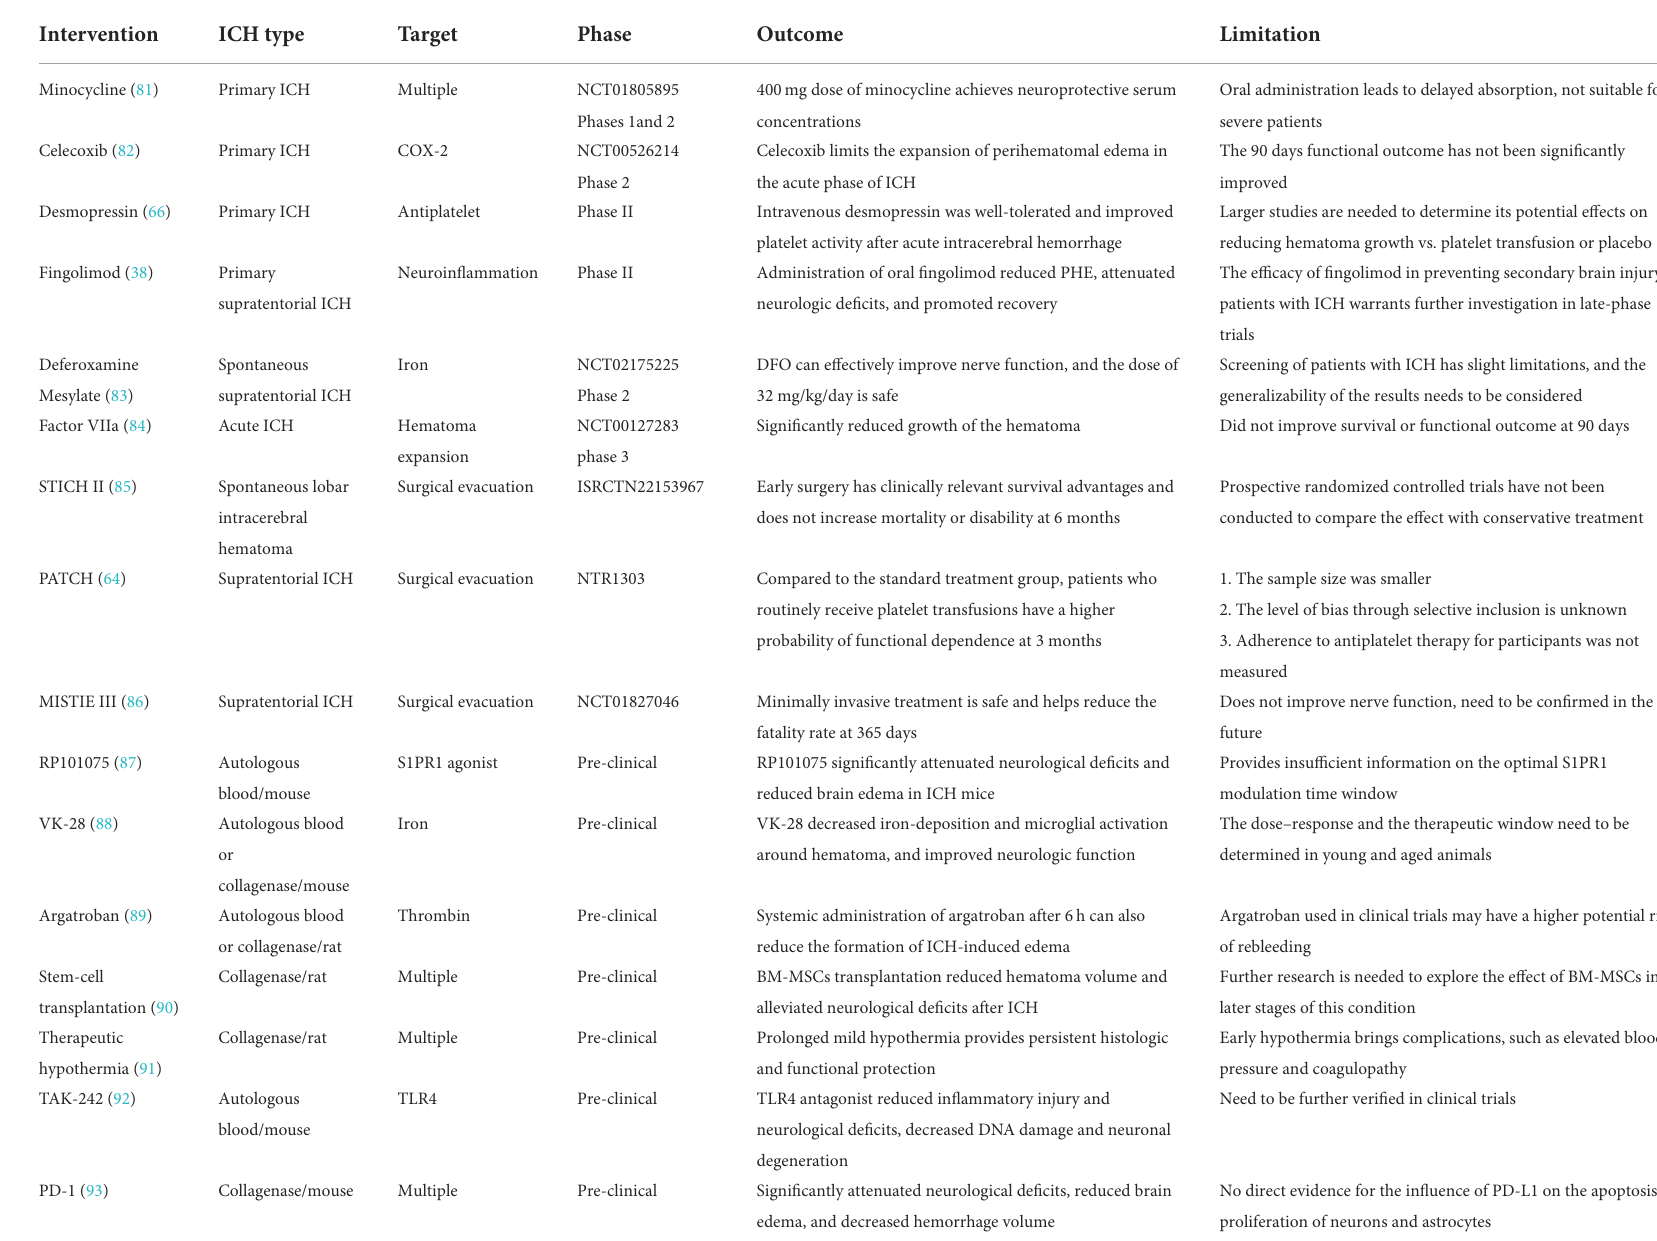
TABLE 1 Current and past therapeutics for intracerebral